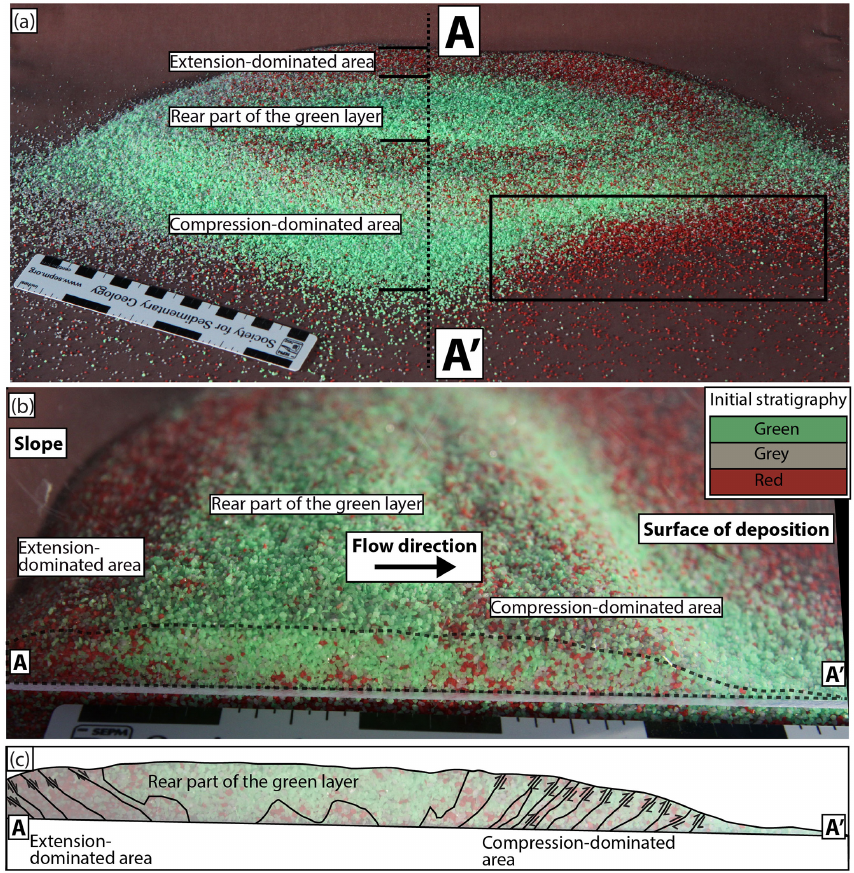
Figure 11. (a) Analog result of the experiment carried with three colored sands (Fig. 10); (b) cross section AA (cid:48) through the center of the analog deposit; (c) interpretation of the cross section AA (cid:48) .